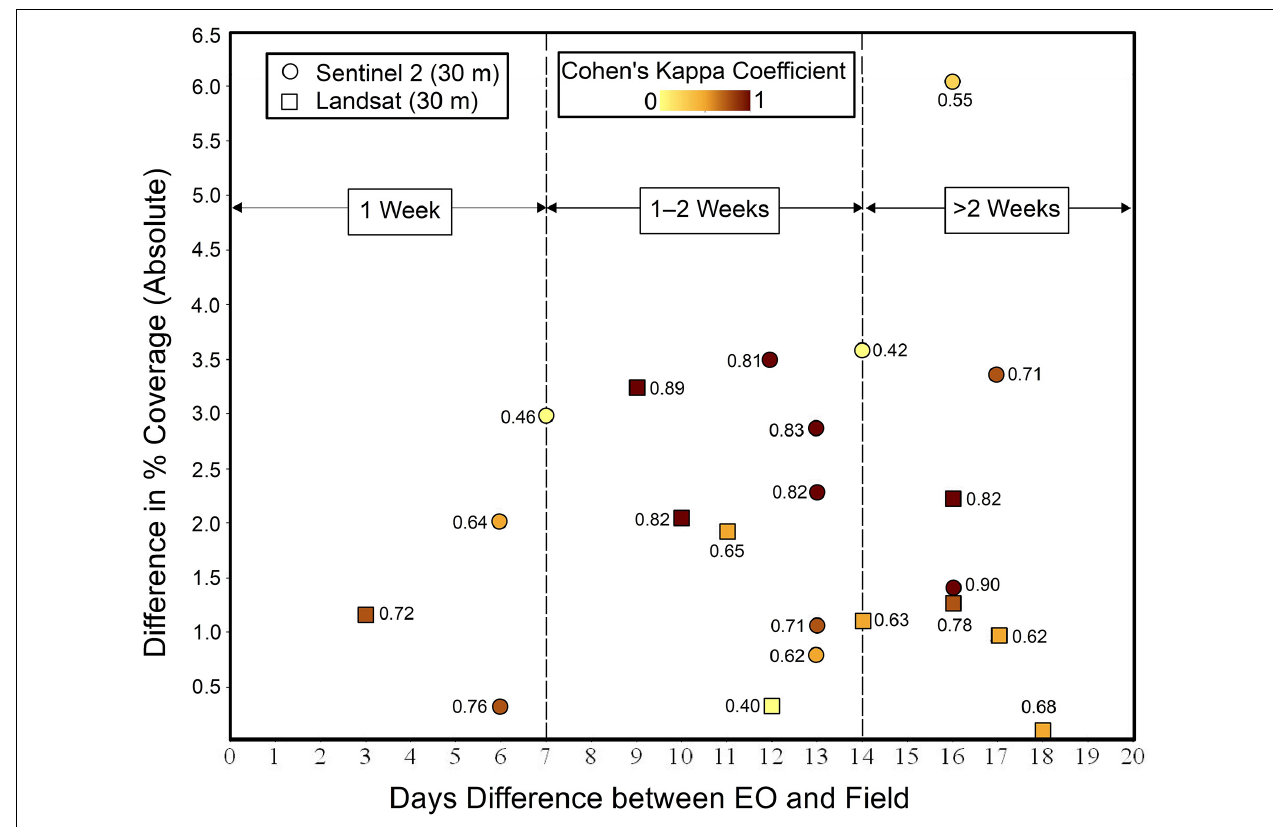
FIGURE 7 | The scatter plot for the time gap between EO and field surveys versus the difference in percentage coverage. The number next to each observation and the intensity of color represent Cohen’s kappa coefficient and its